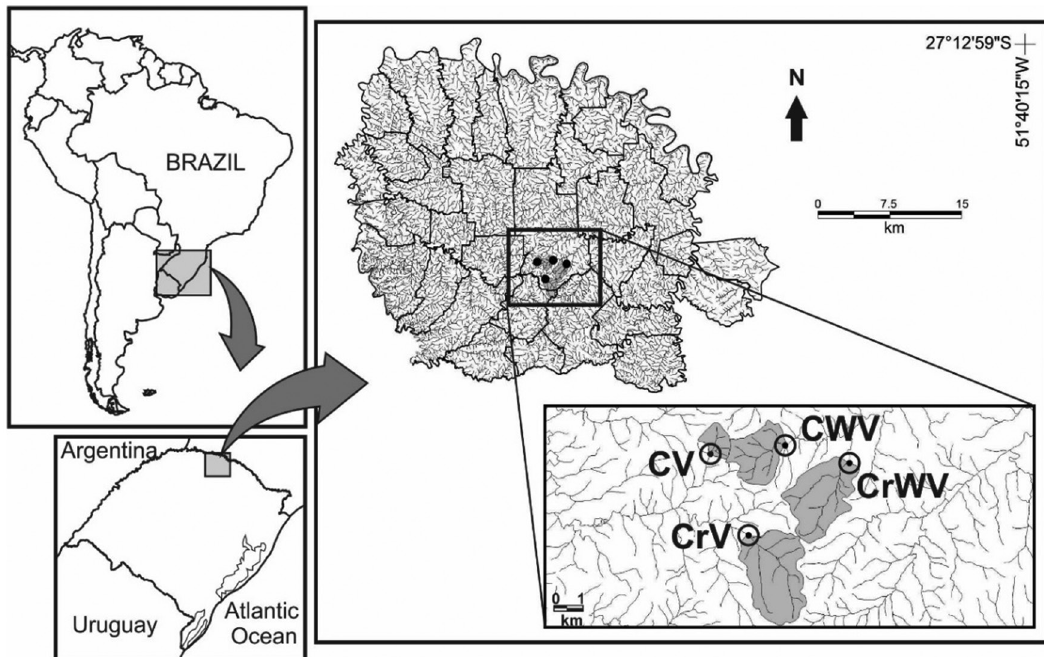
Figure 1. Localization of the streams in the Campo river hydrographic sub-basin and Cravo river hydrographic sub-basin, Southern